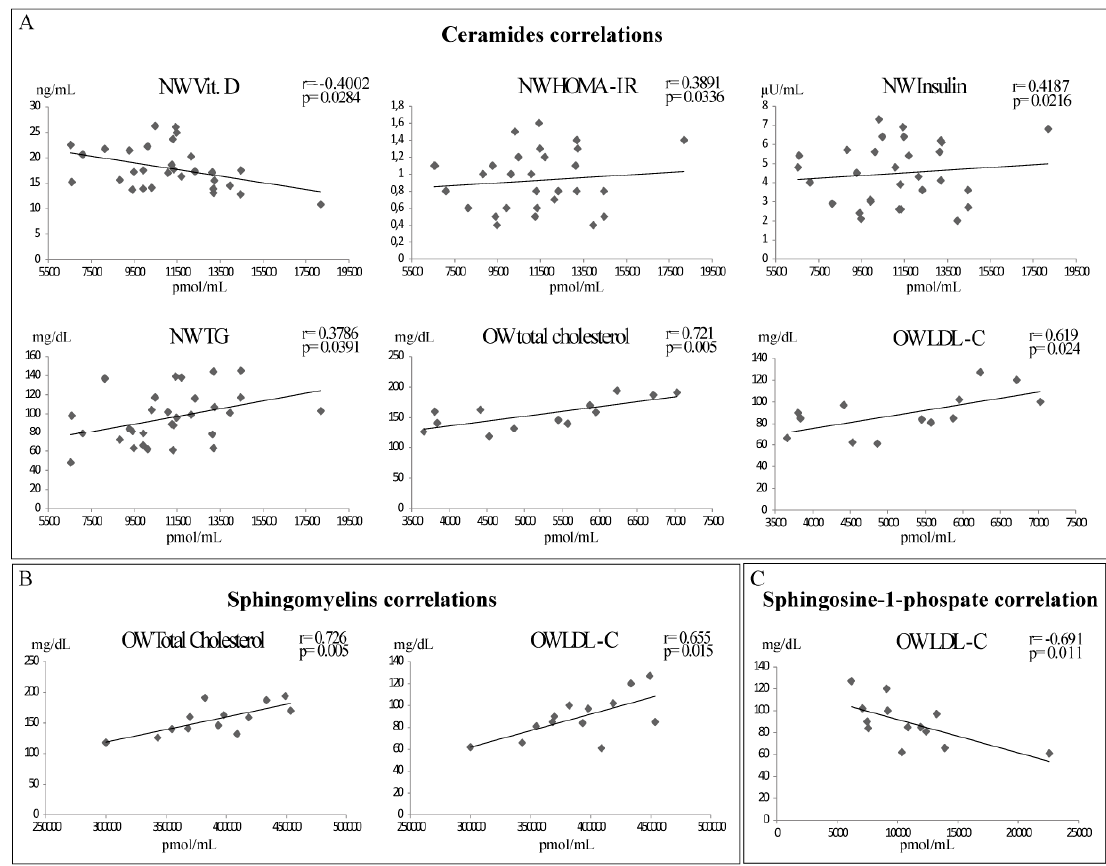
Figure 1. Total Ceramide ( A ), total sphingomyelin ( B ), and total S1P ( C ) scatter plots. Data for cers, SMs, and S1P are expressed as pmol / mL in log scale; data for Vitamin D are in ng / mL and data for insulin are in µ U / mL; TG, TC, and LDL-C are in mg / dL; p -values from two tailed test, r value from Pearson’s correlation.